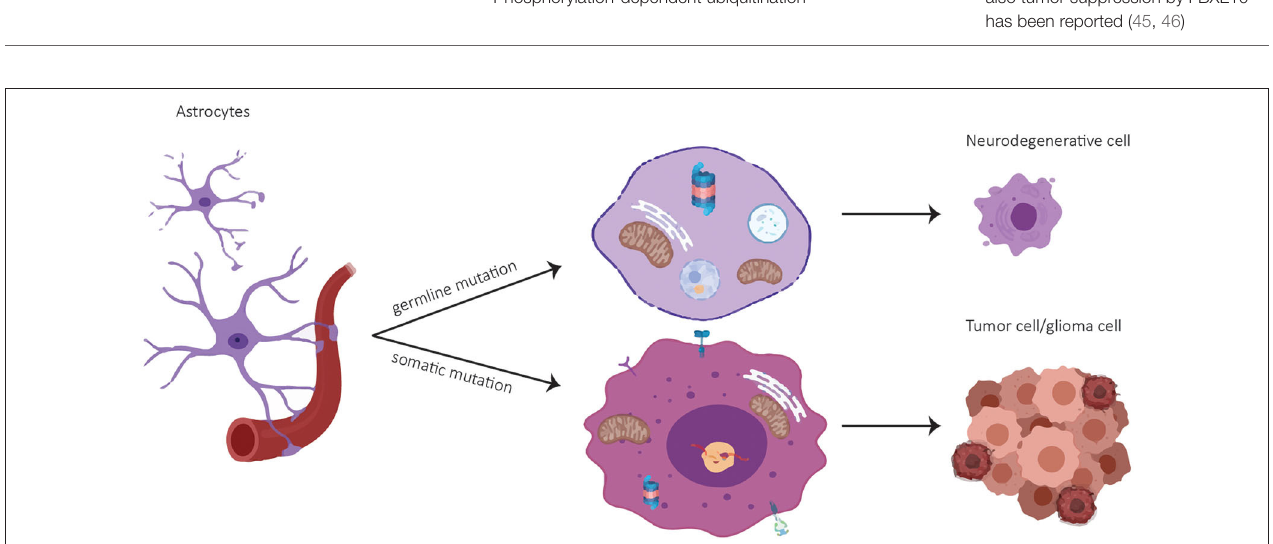
FIGURE 1 | Cell fate of astrocytes depending on mutational status. A germline mutation in a PD-associated gene might result in a neurodegenerative cell whereas a somatic mutation can lead to a tumor cell.